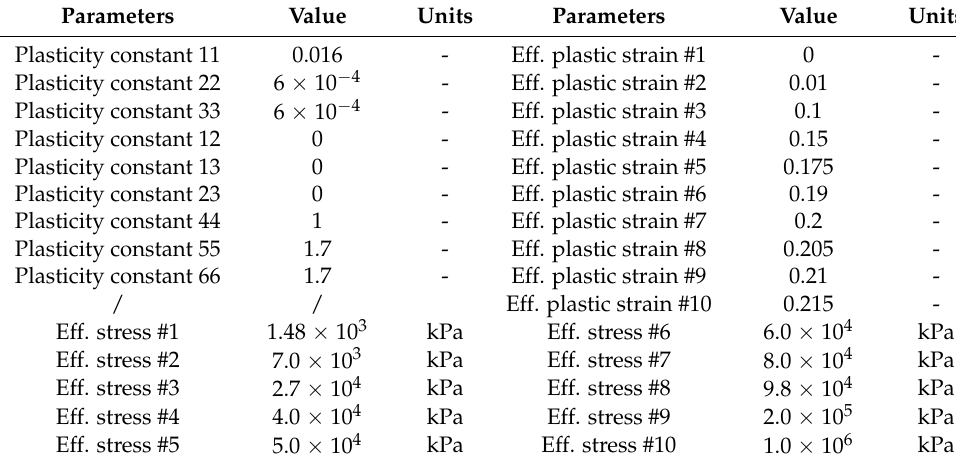
Table 6. Material constants for Orthotropic yield